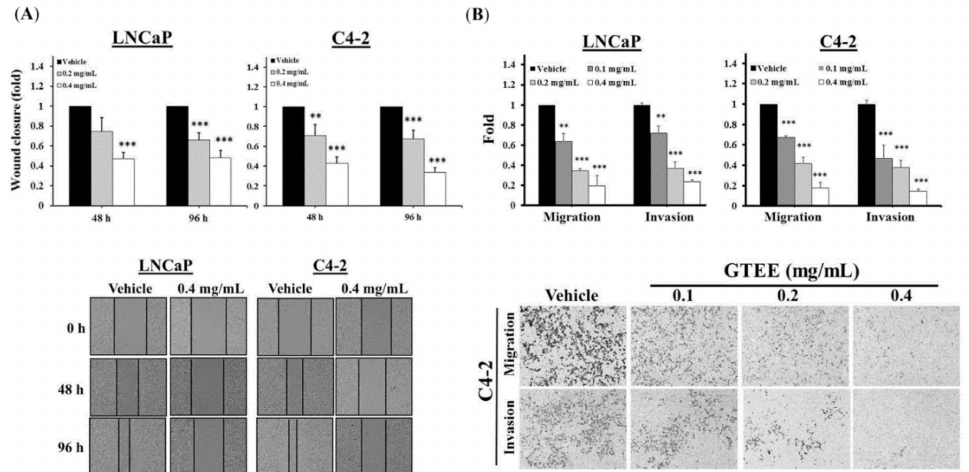
Figure 4. GTEE inhibits the in vitro progression of PCa cells. ( A ) LNCaP and C4-2 cells were treated with vehicle (0.3% ethanol) or GTEE (0.2 or 0.4 mg/mL). Wound closure was determined by migratory distance at 48 and 96 h. Data were shown as the mean ± SD of three independent experiments. ** p < 0.01, *** p < 0.001 (top panel). Representative images of wound closure in LNCaP and C4-2 cells treated with vehicle or GTEE (0.4 mg/mL) were shown (bottom panel). ( B ) The migration and invasion of LNCaP and C4-2 cells treated with vehicle (0.3% ethanol) or GTEE (0.1, 0.2 or 0.4 mg/mL) were performed by the Boyden chamber method. Data represented the mean ± SD of three separate experiments. ** p < 0.01, *** p < 0.001 (top panel). Representative images of the migration and invasion of C4-2 cells treated with vehicle or GTEE were shown (bottom